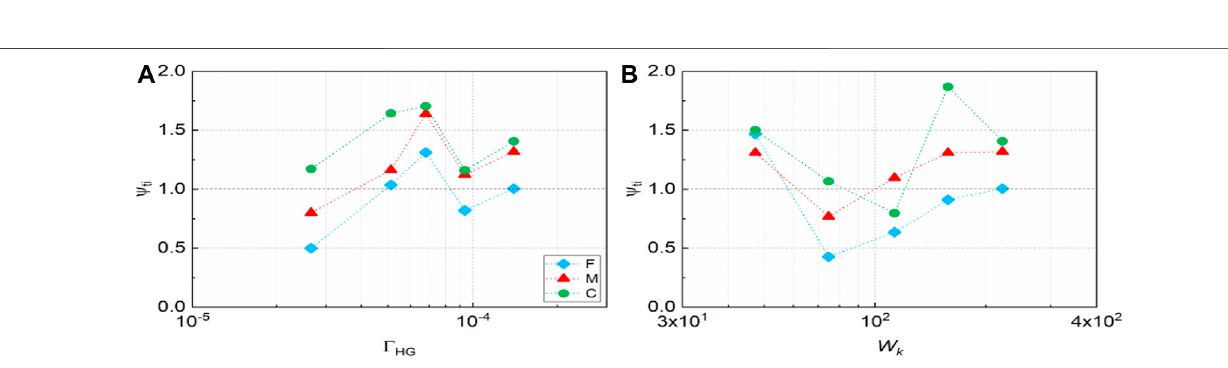
FIGURE 7| Summary of (A) fractional stress threshold-motion ratio ψ ri values for all symmetrical hydrographs for fi ne F , medium M and coarse C size classes, and (B) corresponding hysteretic modes compiled separately on the basis of bed load rates q bi under CW, N/M and CCW hysteresis behaviour.